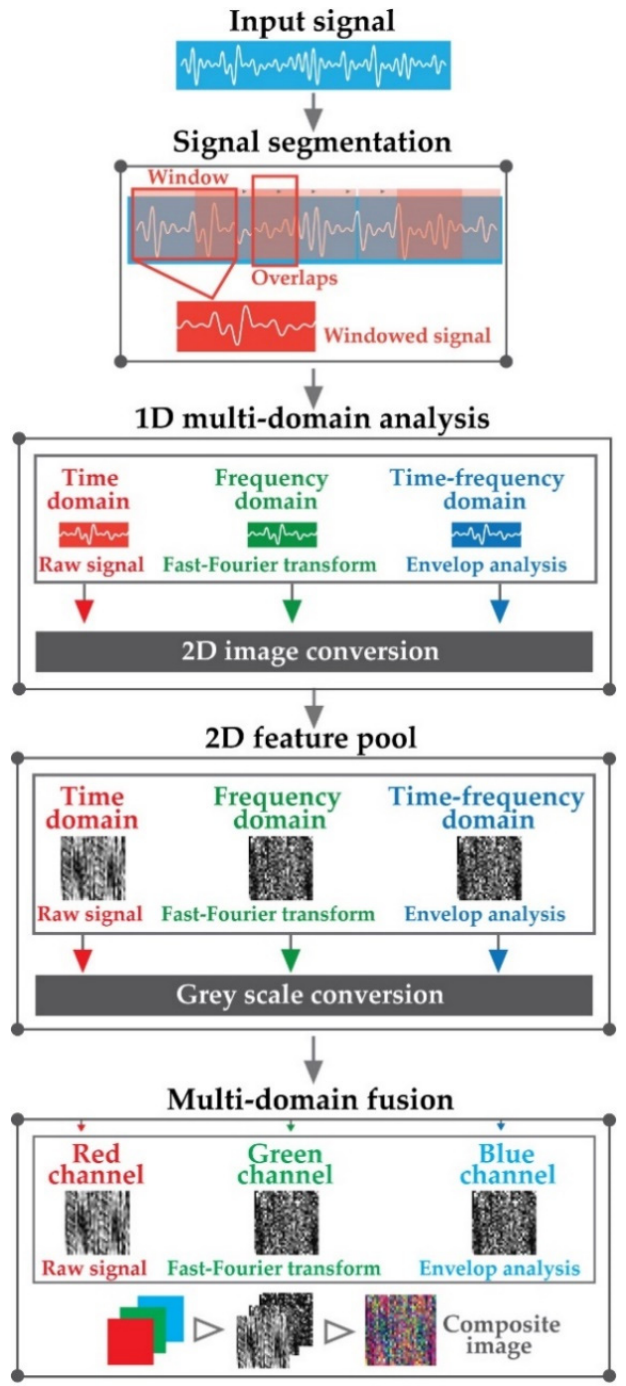
Figure 4. Process diagram of multi-domain fusion-based vibration imaging (MDFVI).